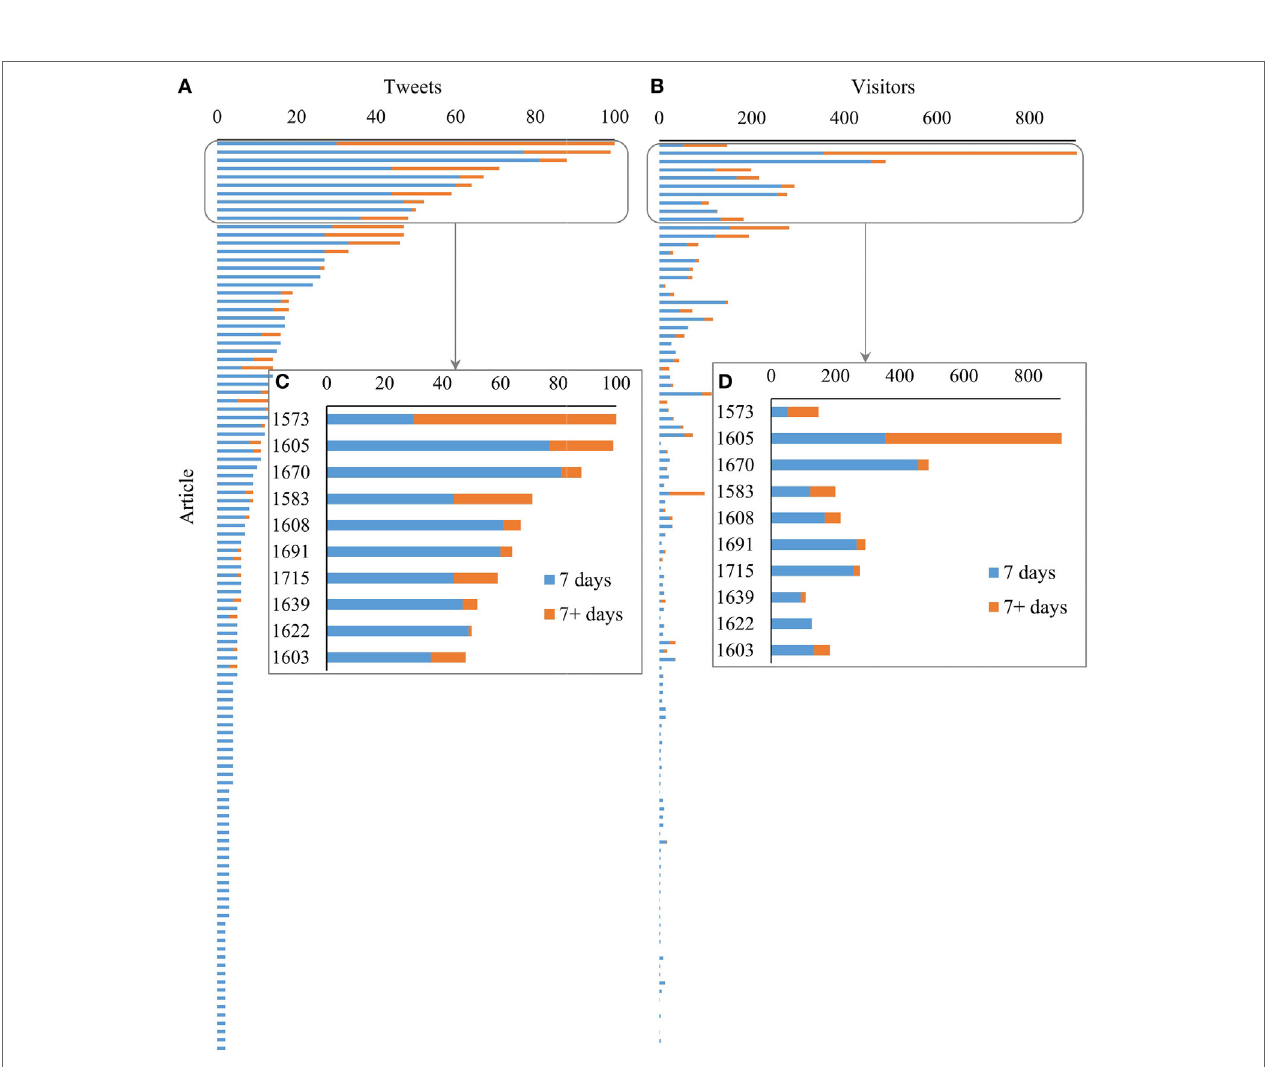
FigUre 6 | Distribution of tweets and Twitter-directed visitors for each paper in two periods after publication. (a) Distribution of tweets for each paper. (b) Distribution of visitors for each paper. (c) The enlargement of the top 10 papers with the most tweets. (D) The enlargement of 10 papers with the most visitors.